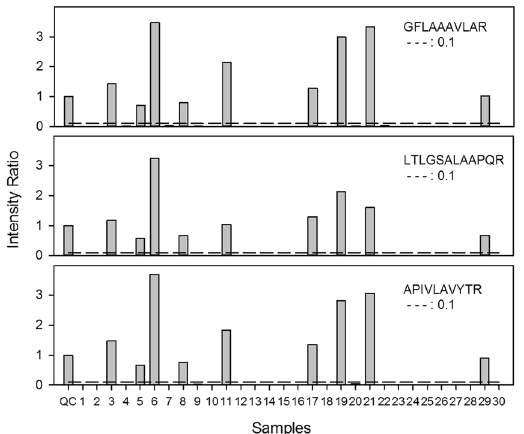
Figure 2. Relative intensities of the three selected KPC peptide markers shown for consecutive validation samples #1–30. The intensity was normalized to daily positive controls, tested as the first and last sample of each testing day. Samples 3, 5, 6, 8, 11, 17, 19, 21, and 29 were called positive in validation and confirmed to be KPC positive by